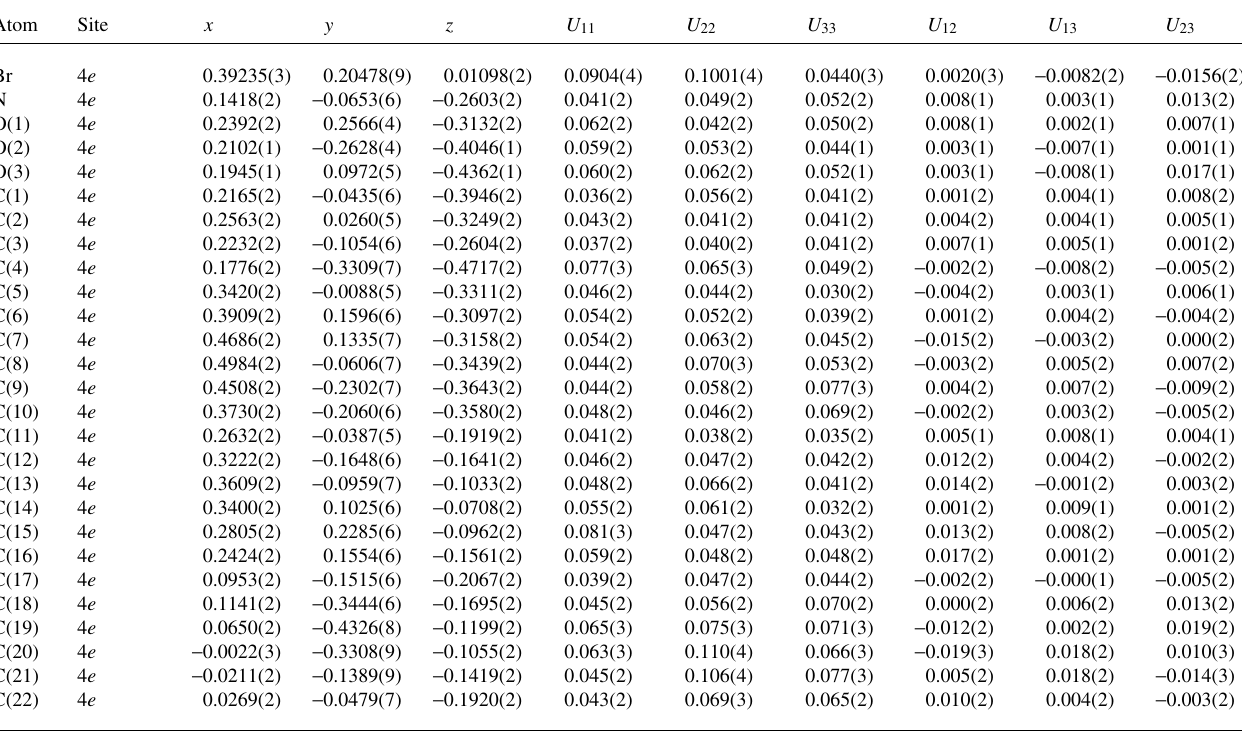
Table 3. Atomic coordinates and displacement parameters (in Å 2 )